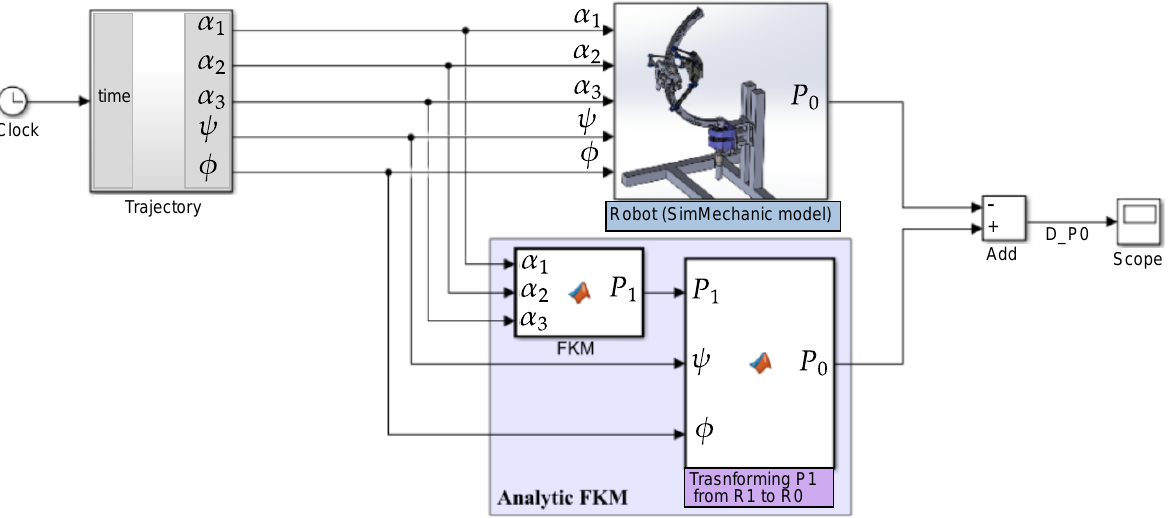
Figure 13. Simulink diagram to compare the analytic FKM model with the numerical model exported from SolidWorks to SimMechanics.